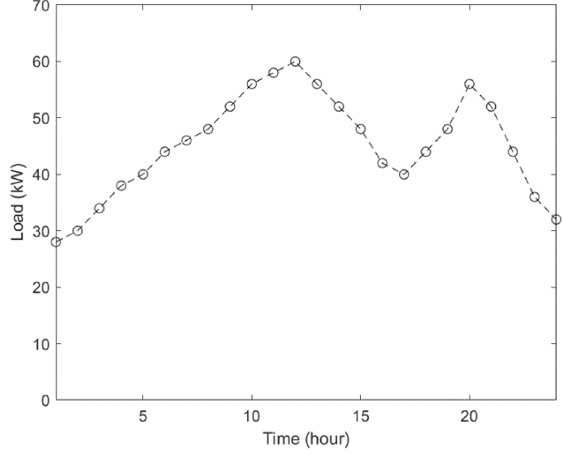
Figure 5. Daily load demand.